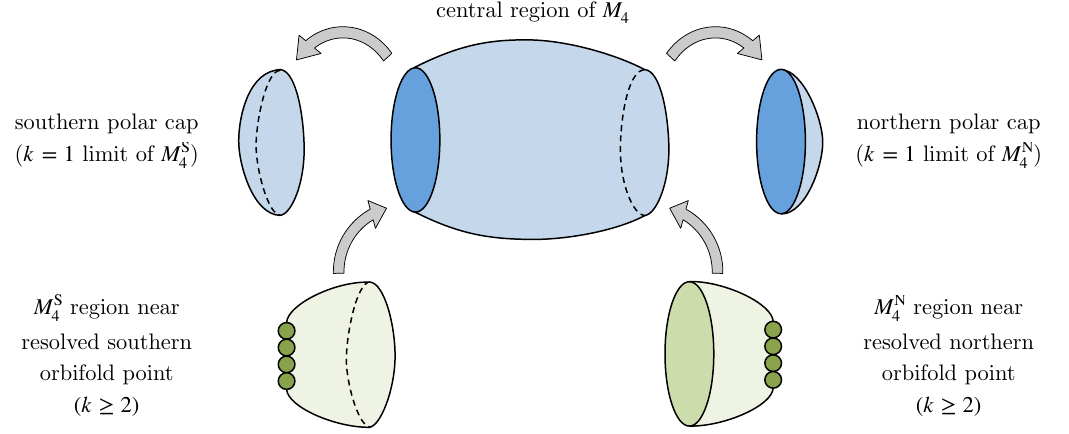
Figure 3. Pictorial depiction of the strategy used to evaluate the E 4 X 8 contribution to the inflow anomaly polynomial. In order to obtain the resolved orbifold M , we consider the central “cylindrical” 4 region of S 4 away from the poles, and we glue in the resolved orbifolds at each pole. These include resolution 2-cycles, depicted as small green circles in the figure. The central contribution is obtained by taking a full S 4 and removing small polar caps. The contribution of the latter is computed by taking the limit k = 1 in the contribution of the resolved